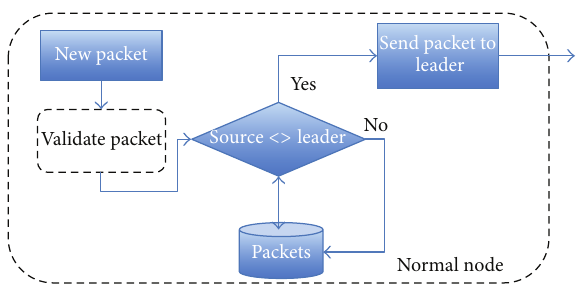
Figure 11: Node flow when a packet is